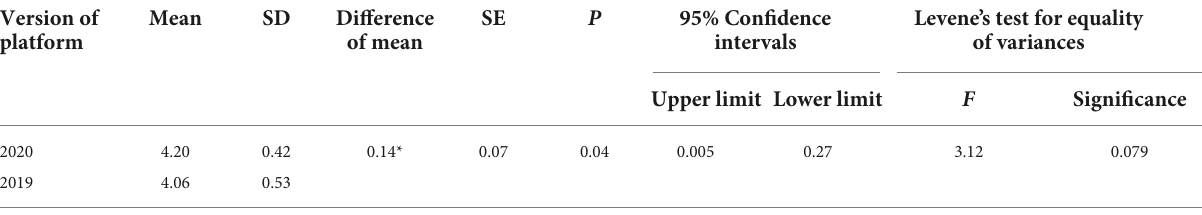
TABLE 7 Independent-sample t -test of the two versions of the platform. Version of platform